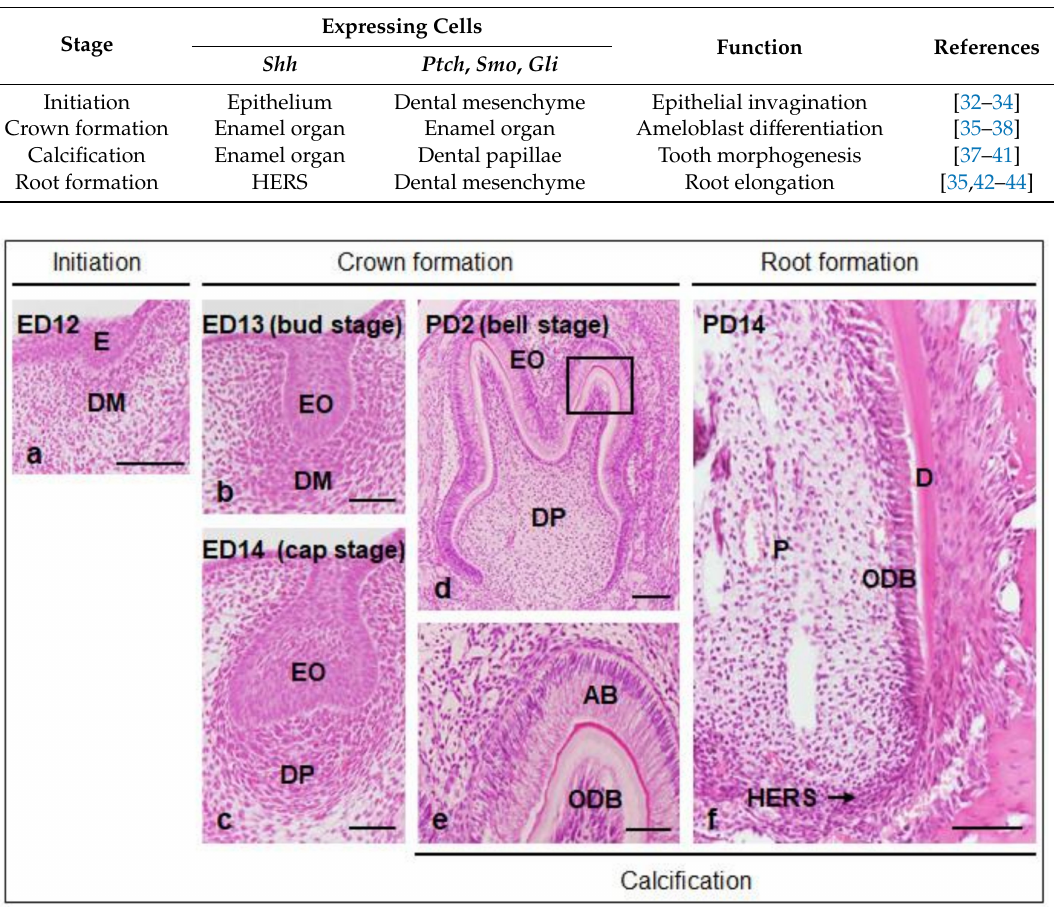
Figure 1. Process of molar tooth development in mouse. ( a–e ) Tooth development begins with thickening of the oral epithelium (E) and progresses to crown (bud, cap, and bell stages) and root formation stages. Calcification of enamel, dentin (D), and cementum occurs after the bell stage. The formation stages “initiation,” “crown formation,” and “root formation” correspond to the terms in Table 1. Higher magnification of the boxed region in “d” is shown in “e.” AB, ameloblast; DM,